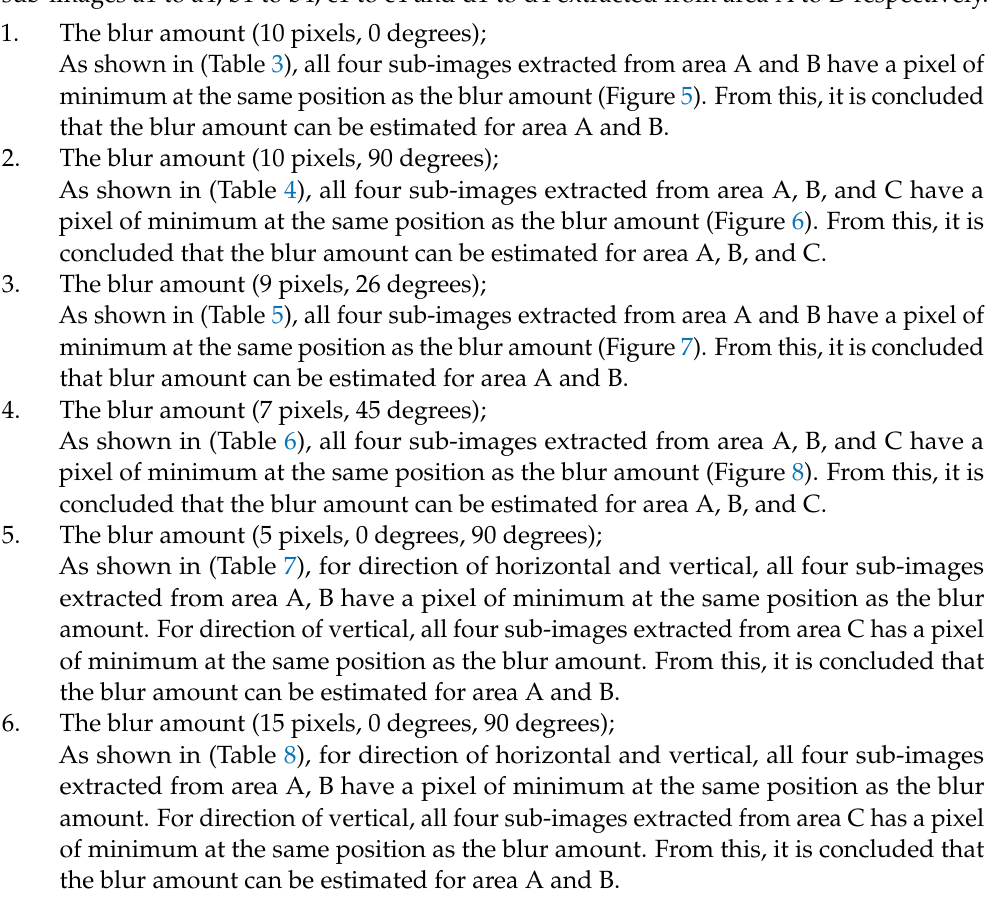
Table 3. The blur amount (10 pixels, 0